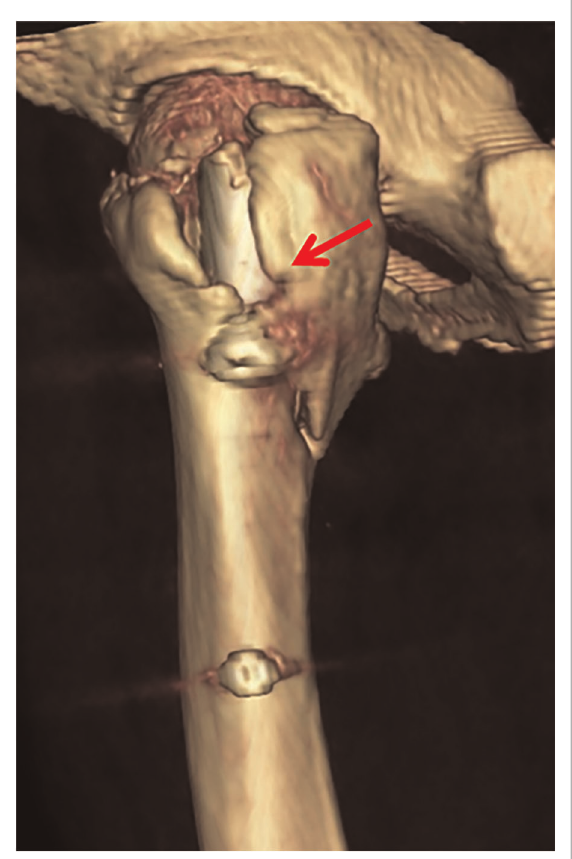
FIGURE 10 Subtype A3.4, with larger posterior coronal fragment involving the entry portal of head – neck implant at the lateral cortex. The arrow indicates an open deformity of the posterior coronal fragment by the helical blade, which may reduce nail stability in the medullary